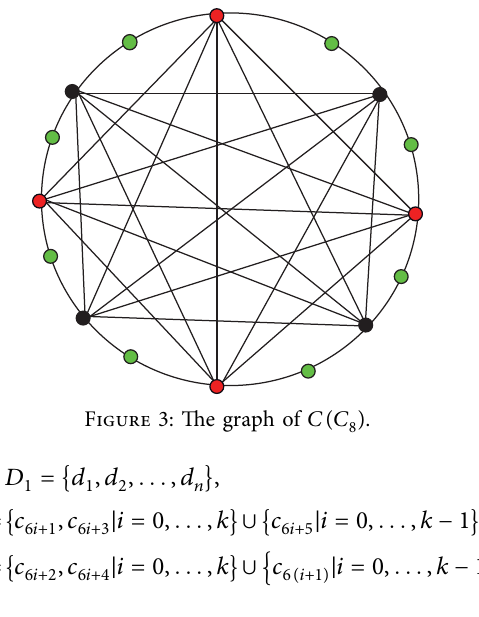
Figure 3: Te graph of C ( C